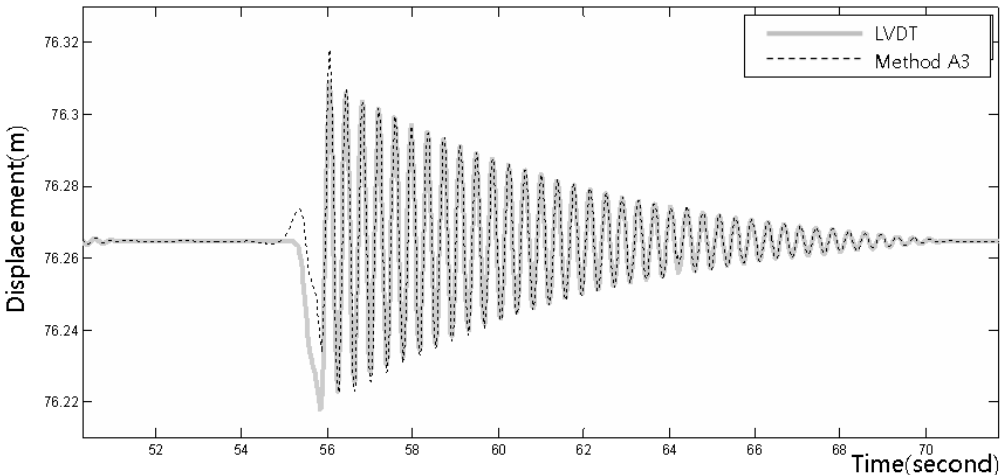
Figure 10. Displacement measurements from the LVDT and the accelerometer (Method A3).